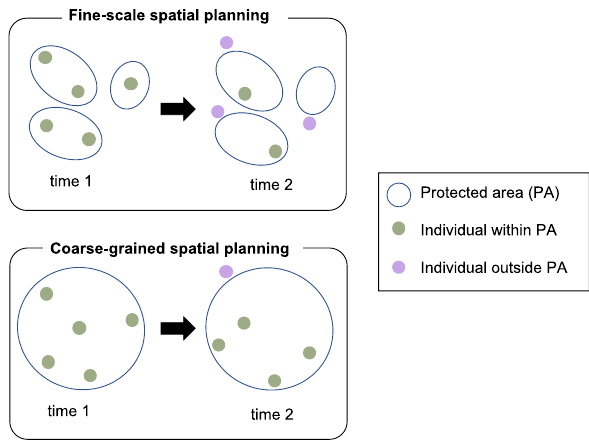
Fig. 2 Schematic image of (top) fine-scale spatial conservation planning (SCP) and (bottom) coarse- grained SCP. A fine-scale SCP allows for highly flexible and compact protected networks. However, it is vulnerable